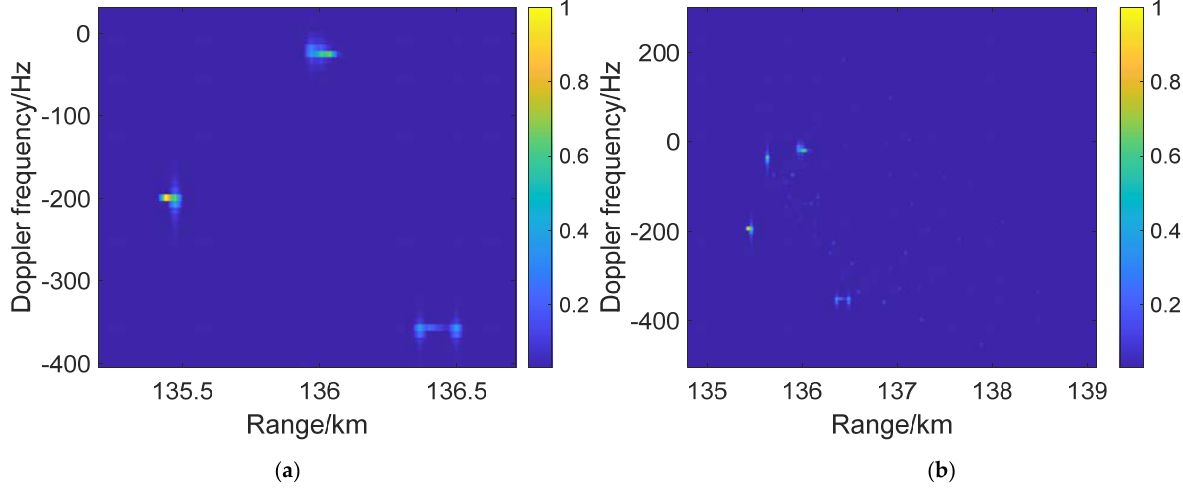
Figure 16. DDM detection results of 3 ship targets under the detection of satellite 3: ( a ) without clutter and noise influence; ( b ) with clutter background.